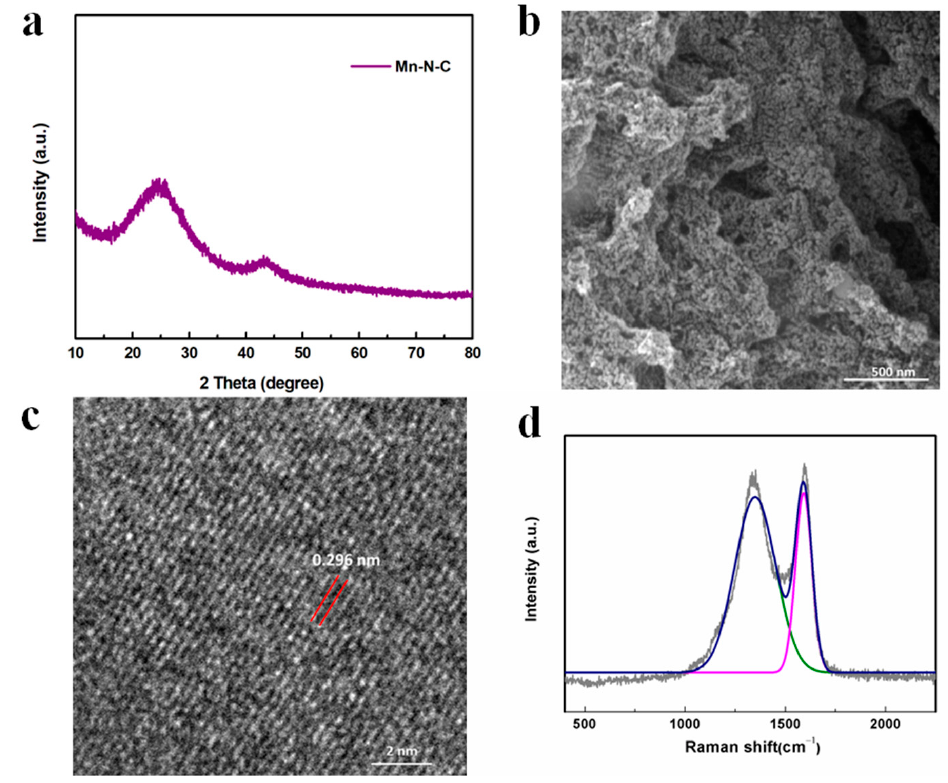
Figure 5. ( a ) XRD pattern; ( b ) SEM image; ( c ) HRTEM image; ( d ) Raman spectrum of Mn-N-C nanostructure. Figure 5. ( a )XRDpattern; ( b )SEMimage; ( c )HRTEMimage; ( d